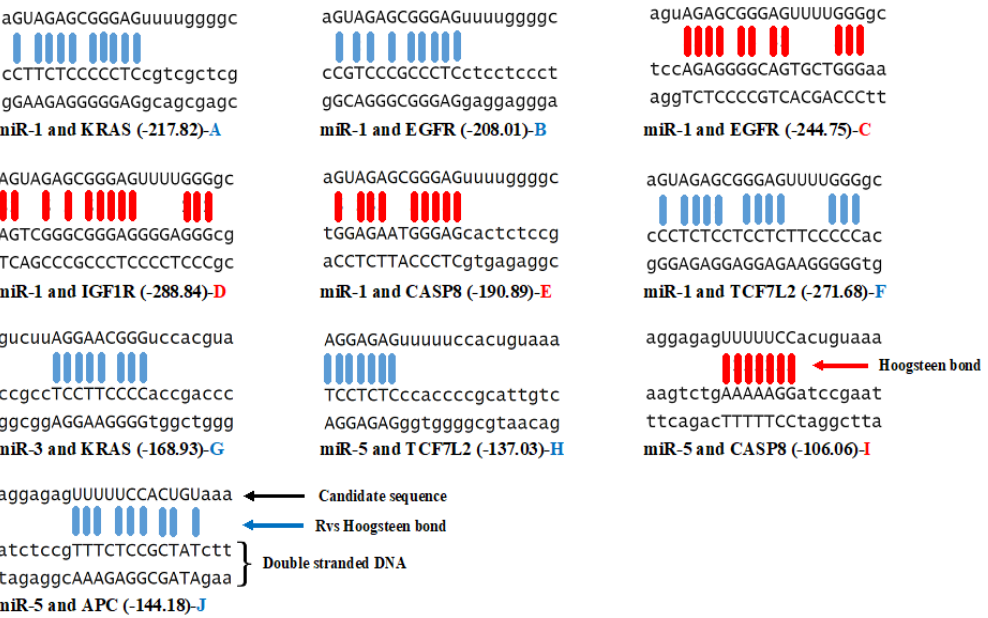
Figure 2. Structural determination of microRNA-DNA triplex formation. The first sequence in each